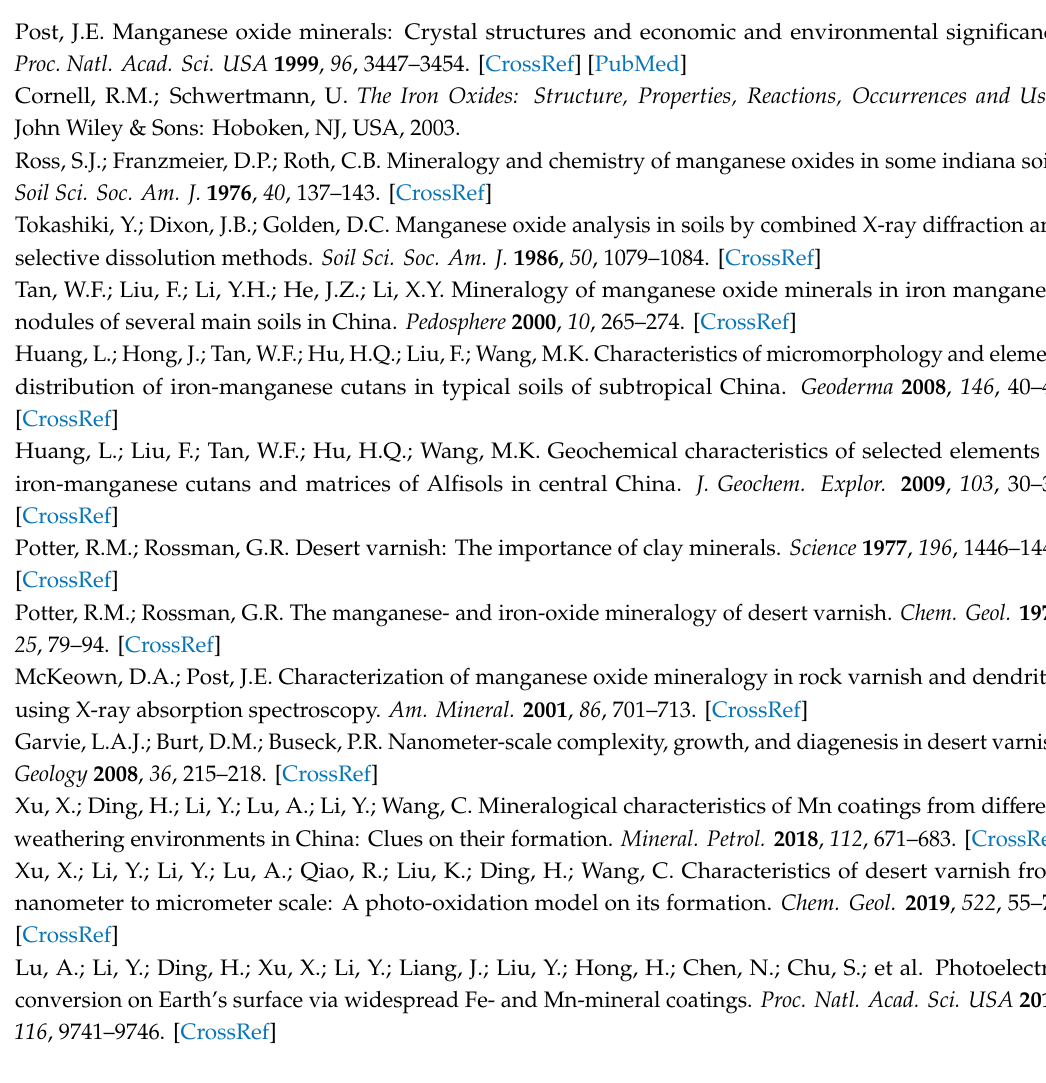
Table S1: Chemical compositions of soil Fe coating. Note: b.d.l. = below the detection limit, Table S2: Chemical compositions of the soil Fe / Mn coating. Spots 1–5 are for the outer Mn-rich layer and spots 6–10 are for the inner Fe-rich layer. Note: b.d.l. = below the detection limit, Table S3: Chemical compositions of the rock Fe coating. Note: b.d.l. = below the detection limit, Table S4: Chemical compositions of the rock Fe / Mn coating. Note: b.d.l. = below the detection